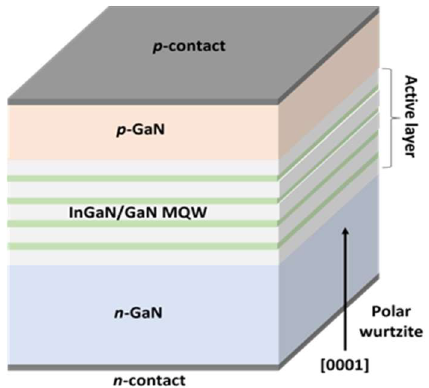
Figure 1. Schematic illustration of InGaN/GaN blue LED structure.